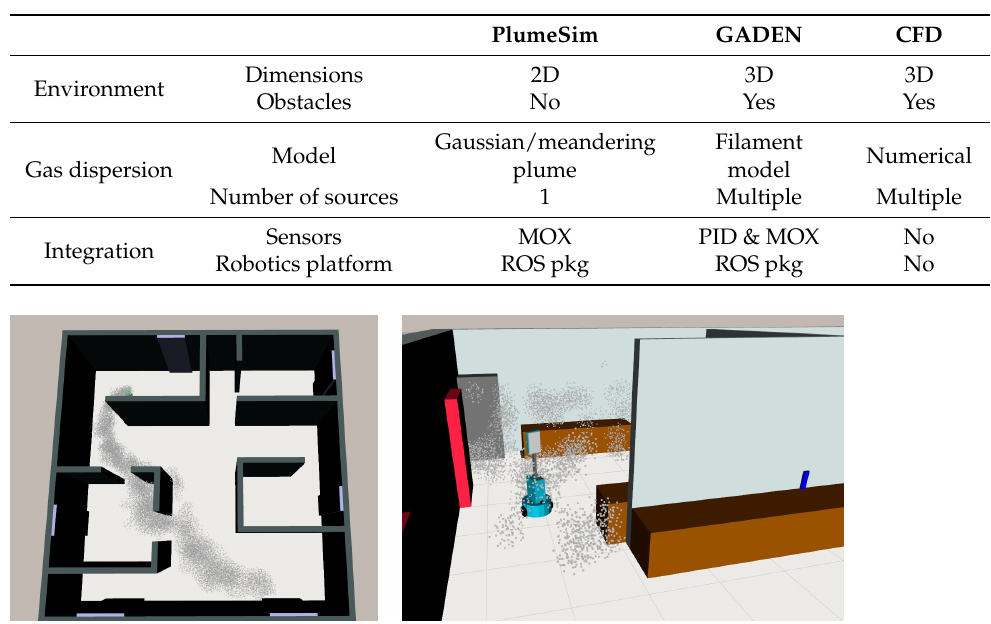
Table 1. Comparison of the features offered by the different alternatives for gas dispersion simulation. Adapted from [17].